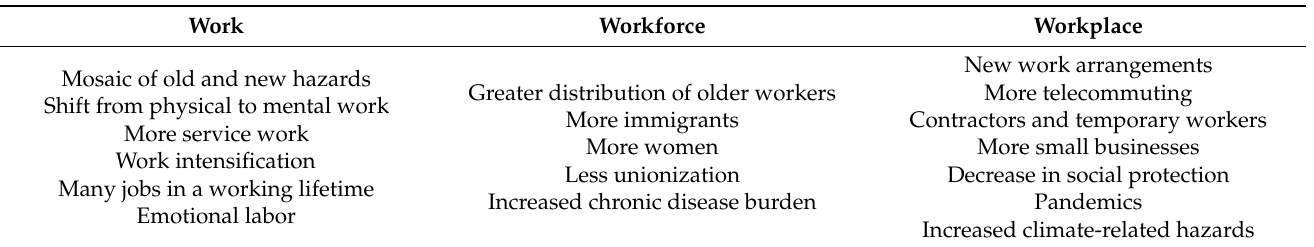
Table 1. The world of work is changing.